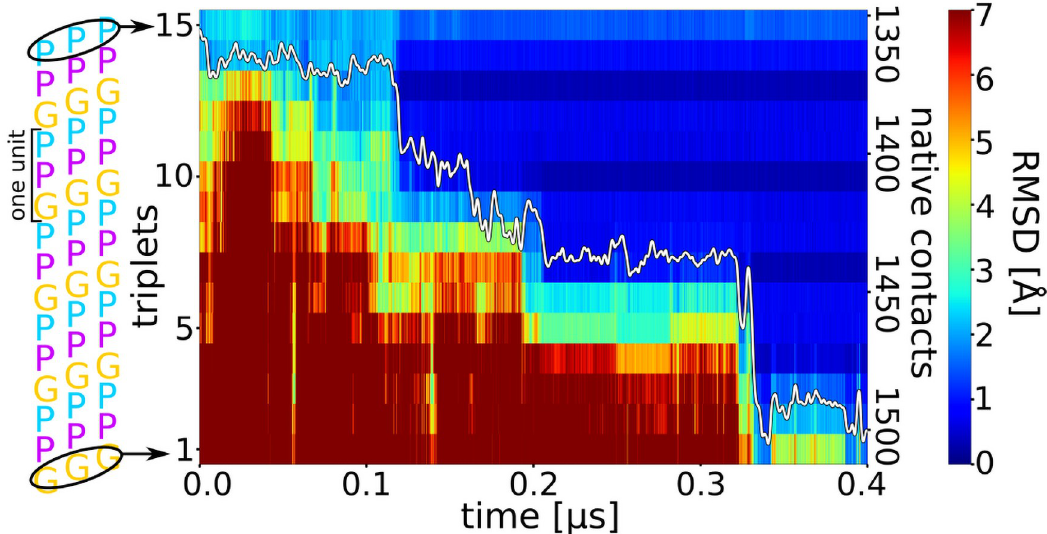
Fig 2. Time course of triple helix formation during an MD simulation. The simulation starts from an unfolded collagen peptide with an already formed nucleus at the C-terminus (see Fig 1A). Each labelled stripe (1–15) represents a residue triplet (residues with same number in each chain, indicated as black ellipse in the left panel) along the three strands. The root-mean-square deviation (RMSD) of each residue triplet relative to the native folded structure is indicated by a color-code (color bar on the right side). A blue color represents sampled states close to native, whereas red color corresponds to an unfolded triplet structure. The y-axis on the right side of the plot gives the number of formed native contacts (white line in the